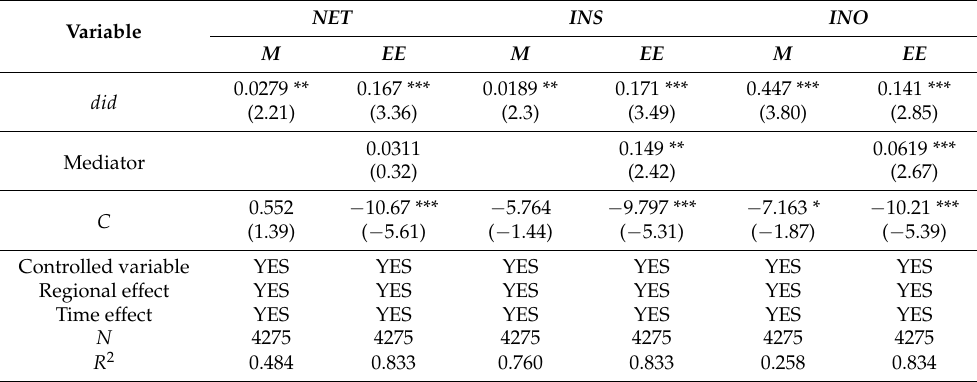
Table 9. Estimation results of influencing